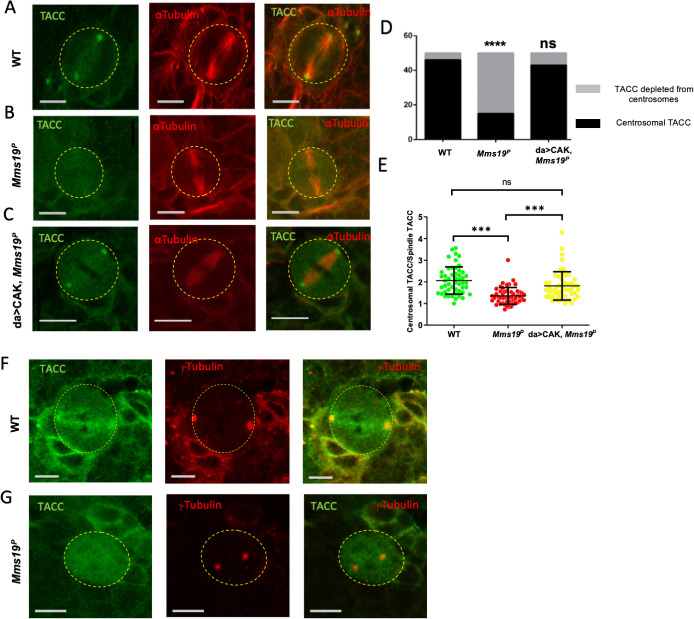
Centrosomal localization of the MT regulator TACC depends on Mms19.(A) A mitotic NB shows TACC localization at the spindle poles. (B, D) >50% of analyzed Mms19p NBs fail to localize TACC to spindle poles. SS was calculated using Fisher’s exact test (****P<0.0001). (C, D) TACC localization was restored upon expression of additional CAK subunits (Cdk7, CycH, and Mat1) in the Mms19P background. (E) The amount of TACC localized on the centrosomes was quantified by comparing the fluorescent intensity of the centrosomal TACC signal to the TACC signal on the spindles. A ratio greater than 1 was considered as clear centrosomal TACC, while a ratio equal to or less than 1 indicated unlocalized TACC. SS was calculated by Kruskal-Wallis test, columns were compared by Dunn’s post test (***P<0.001), scale = 5μm. n = 25 NBs per genotype, 3 experiments. (F, G) NBs were stained with antibodies against γ-Tubulin to test for centrosomal localization. (F) TACC co-colocalized with γ-Tubulin on wild-type centrosomes. (G) In the mutant NB, TACC fails to concentrate at γ-Tubulin foci.